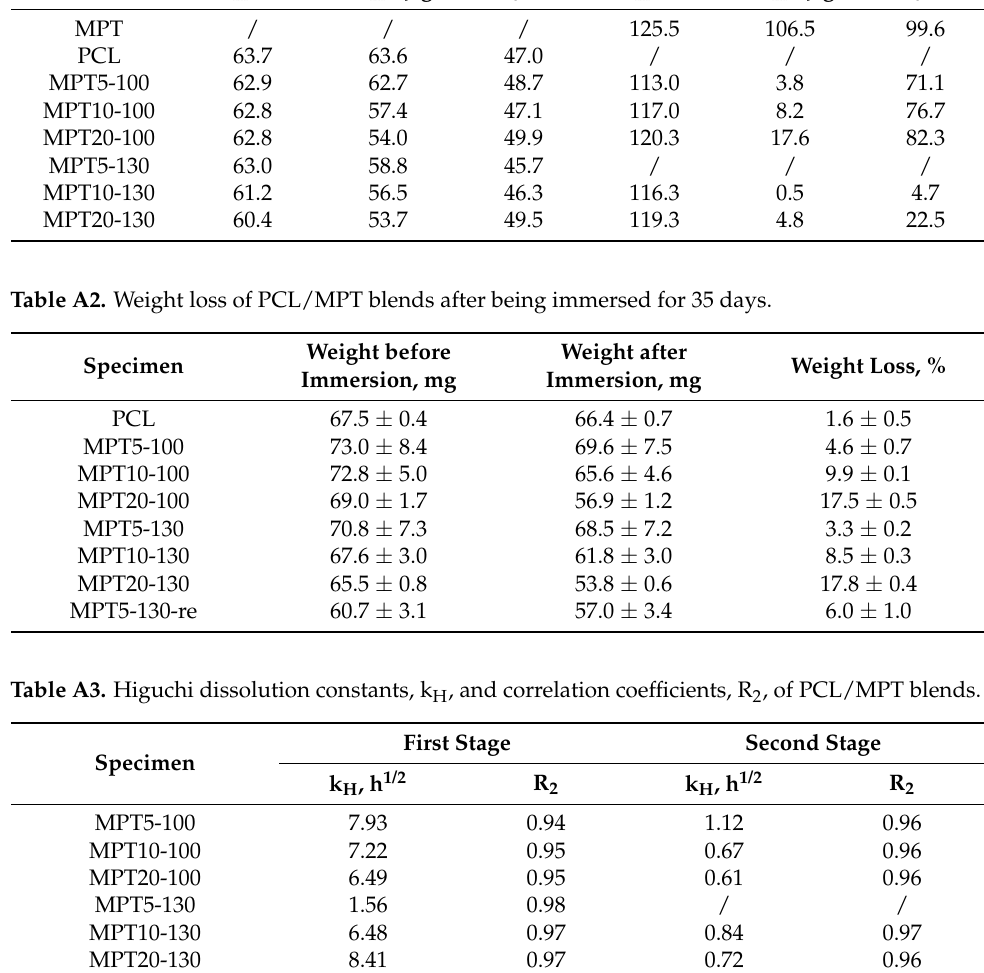
Table A3. Higuchi dissolution constants, k H , and correlation coefficients, R 2 , of PCL/MPT blends. Specimen